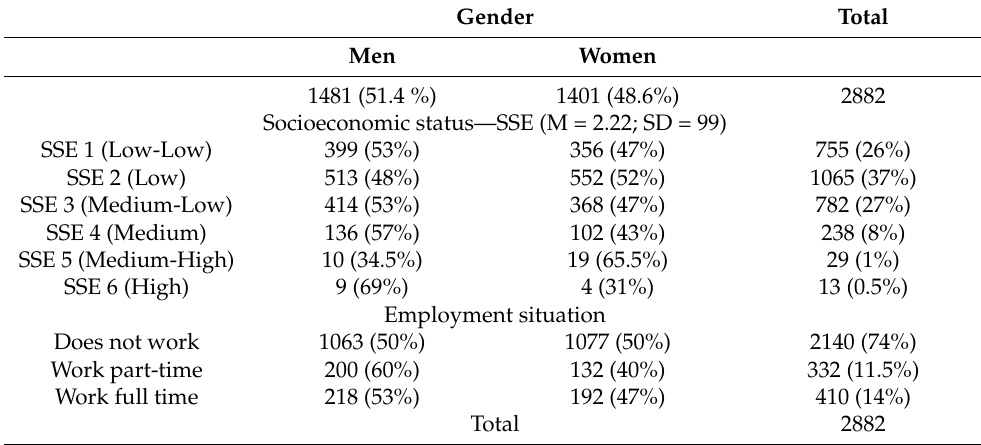
Table 1. Sociodemographic data of the participants: genre, SSE and employment situation. Gender Total Men Women 1481 (51.4 %) 1401 (48.6%) 2882 Socioeconomic status—SSE (M = 2.22; SD =